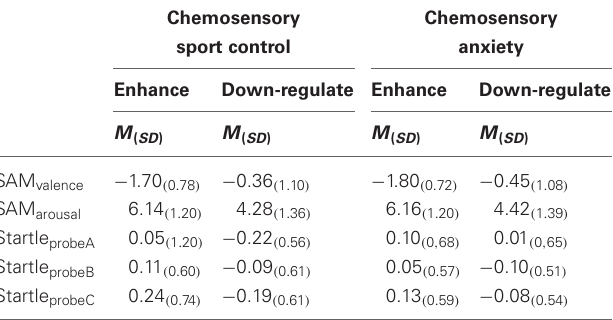
Table 2 | Emotion regulation effects on subjective ratings and the startle reflex toward anxious faces in the context of chemosensory anxiety or sport-control stimuli in Experiment I (Startle).